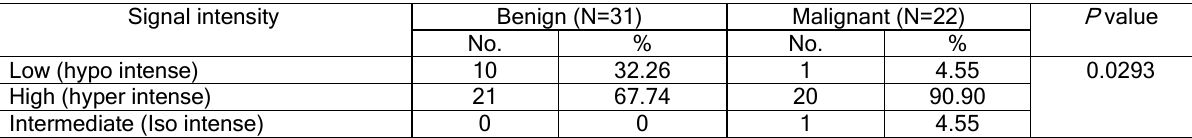
Table 4: Difference in SI on DWI (b value = 1000 s /mm 2) between benign and malignant ovarian lesions. Signal